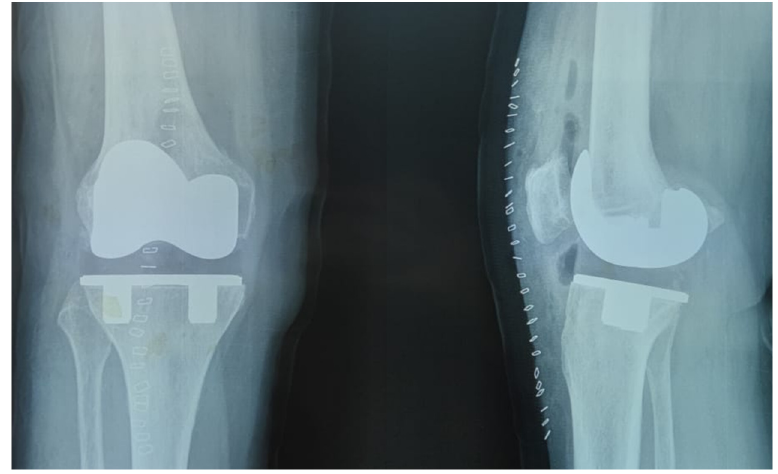
Figure 4. Radiographic image of a TKA using a two-peg monoblock TMT tibial component.